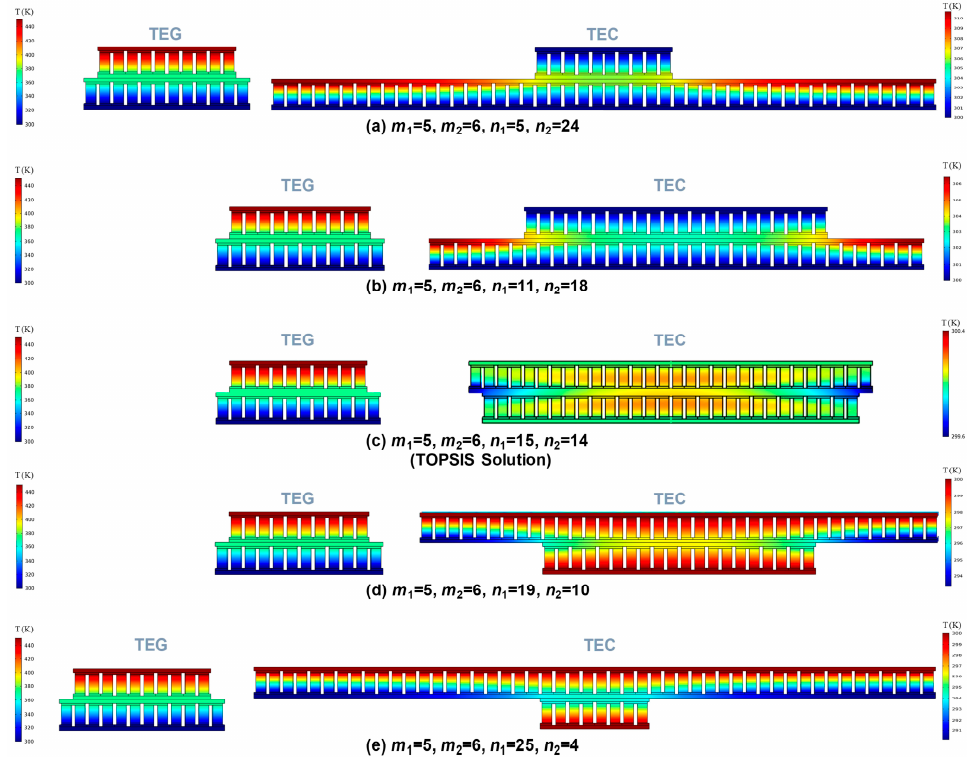
Figure 14. Temperature profiles of the structures with n 1 = 5, 11, 15, 19, and 25, corresponding the results shown in Figure 13a.